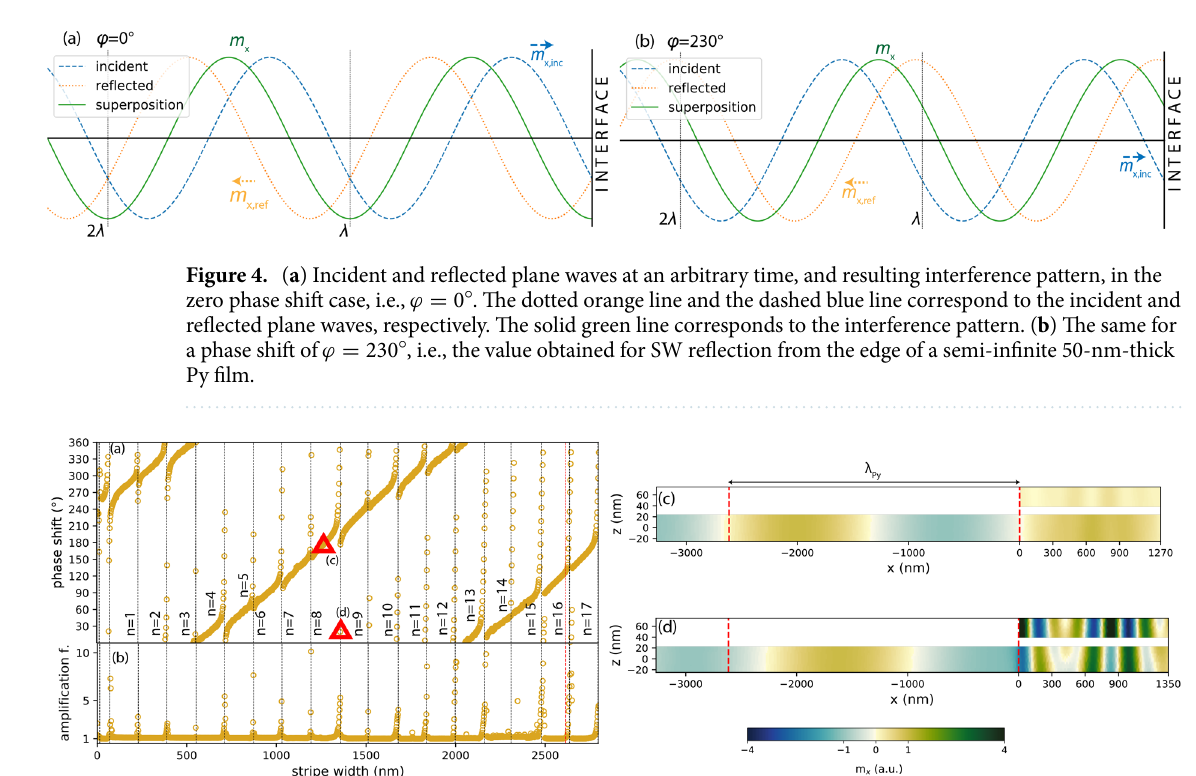
Figure 5. ( a ) Phase shift of SWs at frequency 11 GHz as a function of the stripe width, calculated by the FD-FEM. The stripe-film separation is s = 10 nm. Resonances (rapid changes of the phase shift, marked with vertical dotted lines) appear periodically with a period of ca. 160 nm. ( b ) SW amplification factor in Py below the stripe, obtained by dividing the maximum of | m x | in the part of the film lying below the stripe by the maximum of | m x | in the far field. ( c ) Snapshot of the dynamic magnetization m x in a plateau region (stripe width: 1270 nm). ( d ) Snapshot of the system in resonance at 11 GHz (stripe width: 1350 nm). The distance between the red dashed lines in ( c , d ) corresponds to the SW wavelength in a uniform Py film at the same